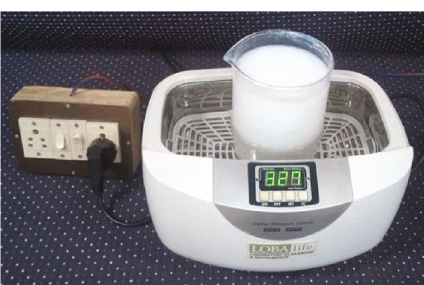
Figure 4: Conceptual design.